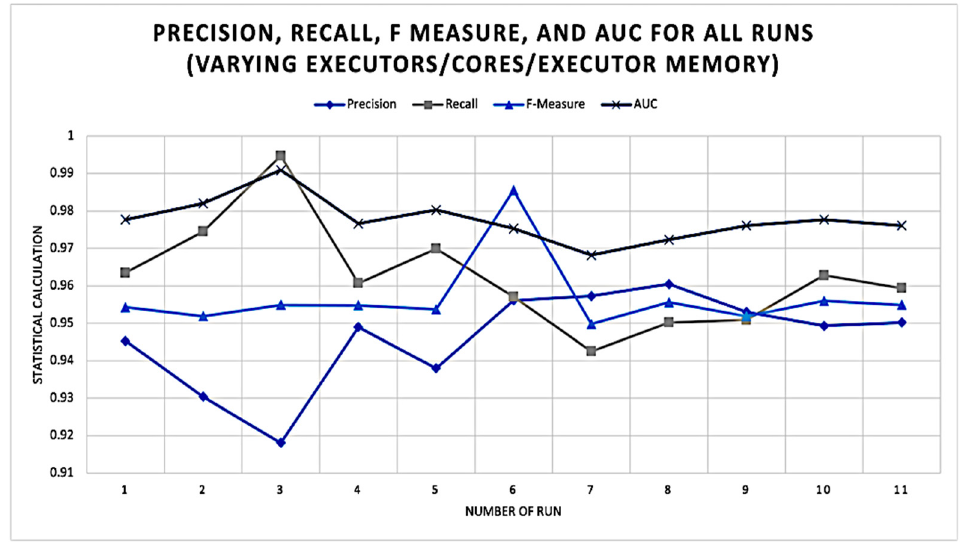
Figure 6. Precision, Recall, F-Measure, and AUC Calculations for all runs (varying execu- tors/cores/executor